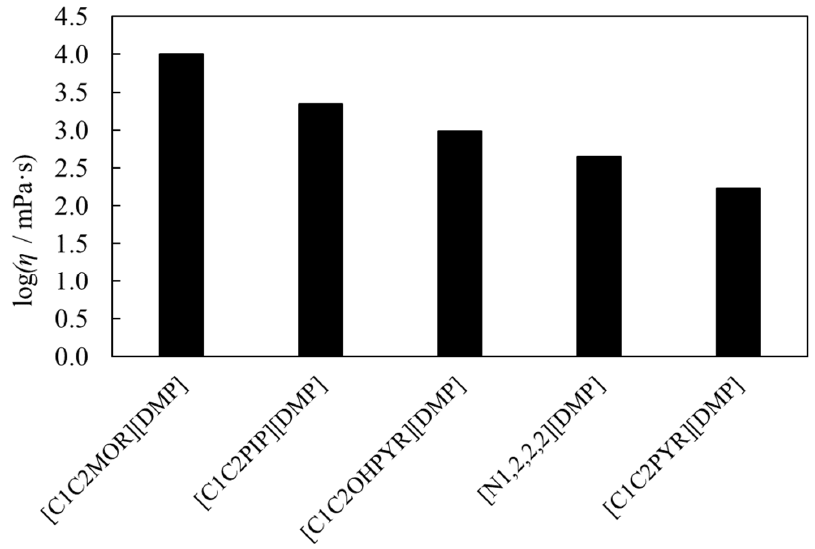
Figure 9. Dynamic viscosity value for pure dimethyl phosphate ‐ based iLs.